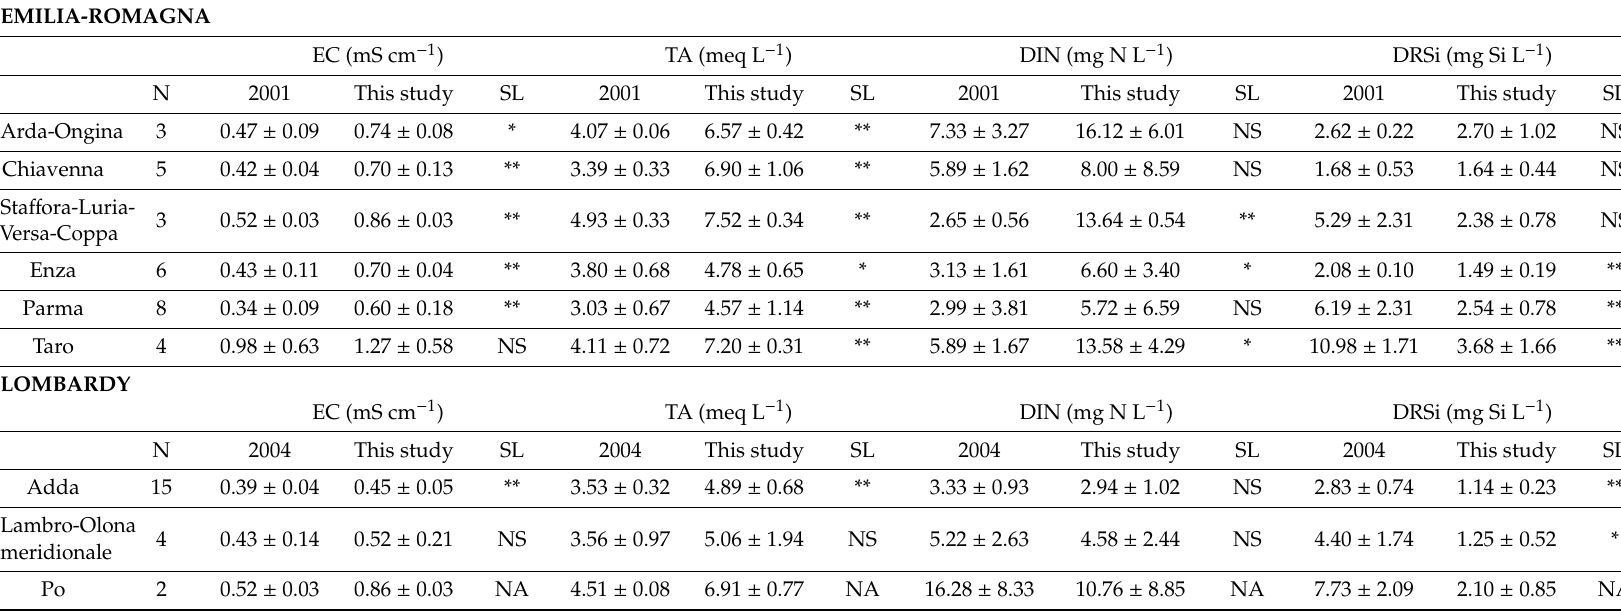
Table 1. Comparison using Student’s t -test of means ± SD for selected physico-chemical variables in di ff erent sub-catchments of Emilia-Romagna (Apennine side) and Lombardy (Alpine side). Data from this study, [10] and [15]. For Lombardy, in 2004, only data collected in autumn are considered. N: number of springs; SL: significance level (NS: not significant; *: p < 0.05; **: p < 0.01); NA: not